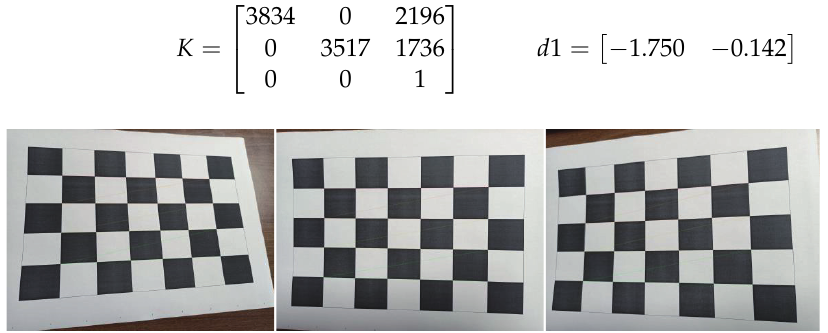
Figure 7. Result of camera